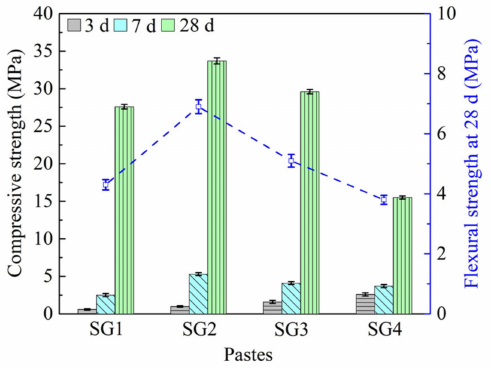
Figure 6. Compressive strength ( left ) and flexural strength ( right ) of the